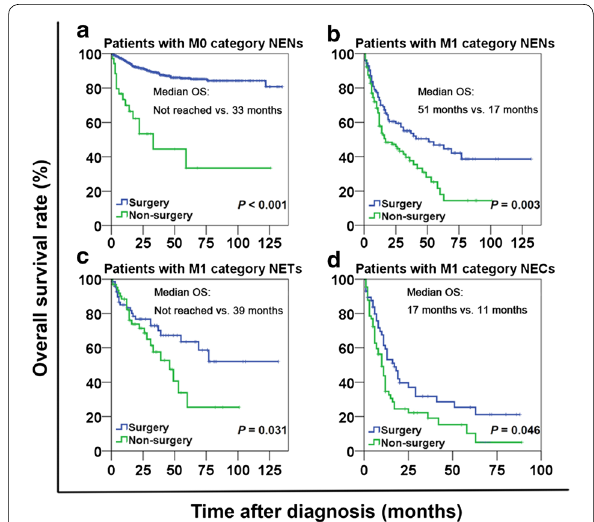
Fig. 2 Patients with neuroendocrine neoplasms (NENs) who underwent surgery had longer OS than those who did not. a OS curves stratified by treatment in patients with M0 category NENs. b OS curves of patients with M1 category NENs. c OS curves of patients with M1 category NETs. d OS curves of patients with M1 category NECs. In the above subgroups, OS is always significantly longer in patients who underwent surgery than in those who did not (all P <